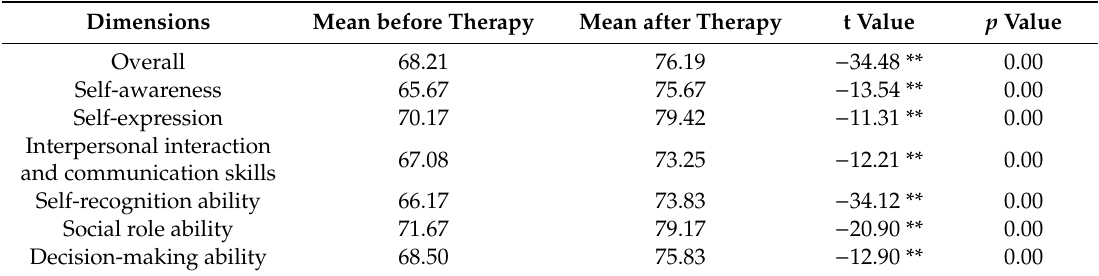
Table 3. Paired t-test: The dimensions of